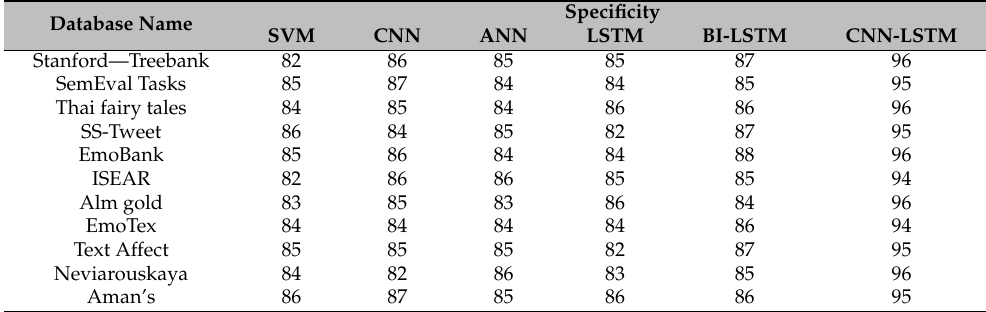
Figure 13. Performance analysis for BOW + IF-IDF with CNN-LSTM based on sensitivity. (“Stanford Sentiment...” means “Stanford Sentiment Treebank”). Table 9. Performance analysis for BOW + IF-IDF with CNN-LSTM based on